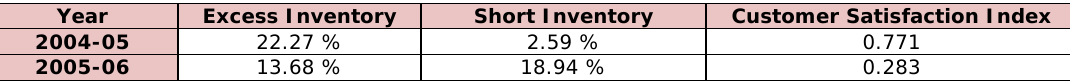
Table 1. “Behavior of inventory and CSI for year 2004-05 and 2005-06”